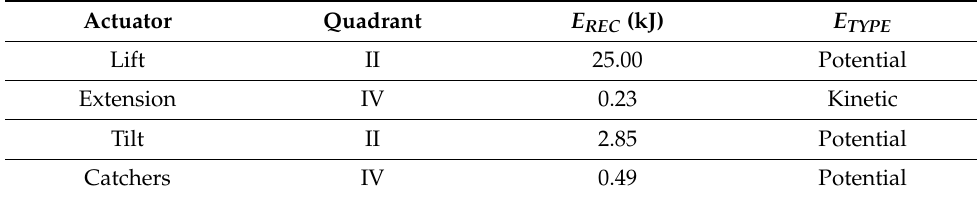
Table 6. Recoverable energy for each actuator in a